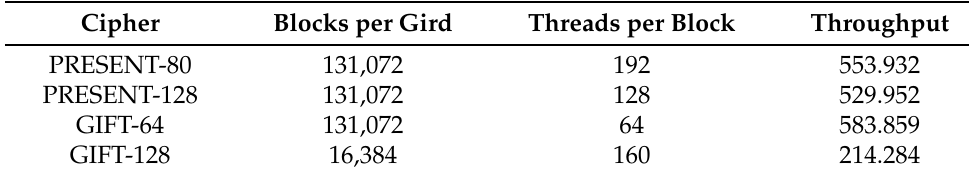
Table 2. The highest throughput results of the exhaustive search version of the proposed technique. The unit of throughput is Gigabit per second (Gbps).